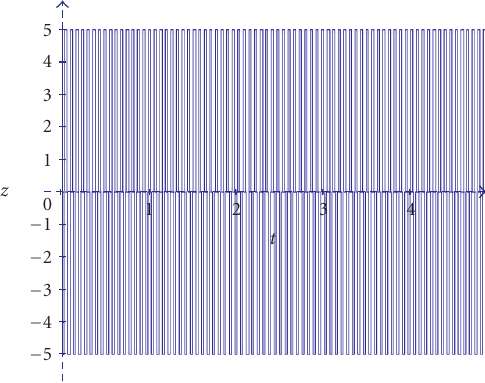
Figure 6.18 . Bounded solution of (5.2) in the point T (923 . 63,125), a 0 = 5.